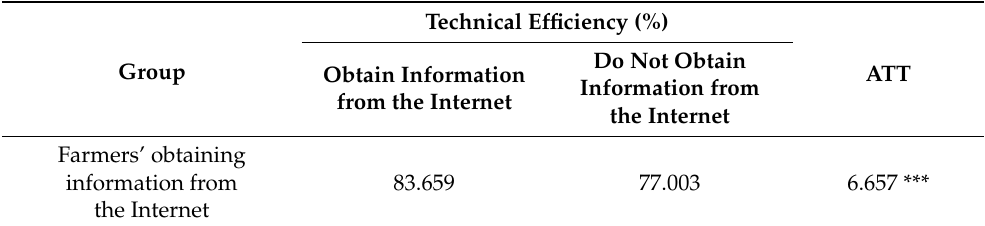
Table 7. ATT of information from the Internet on technical efficiency among farmers. Technical Efficiency (%) Do Not Obtain Group ATTObtain Information Information from from the Internet the Internet Farmers’ obtaining information